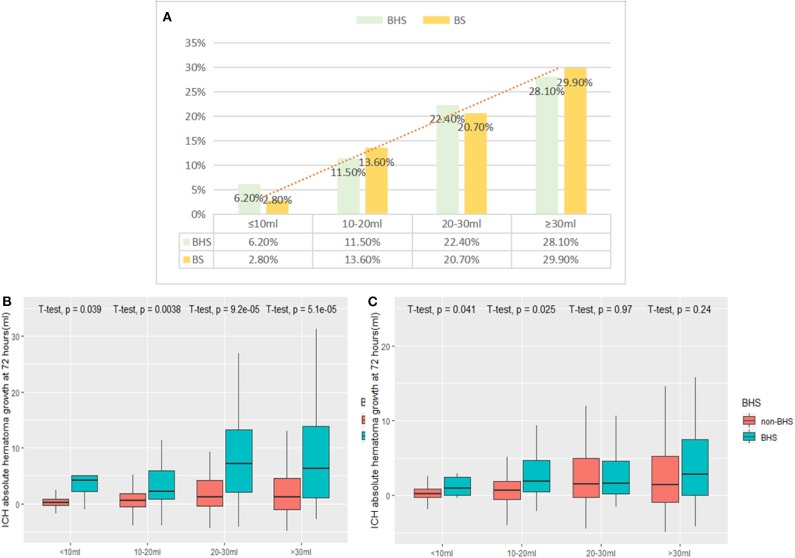
(A) shows the frequency of the BS and BHS, stratified by baseline hematoma volume (both Ps < 0.001). Differences between (B) the BS and non-BS and (C) the BHS and non-BHS scans are shown in the figure. BHS, black hole sign; BS, blend sign.